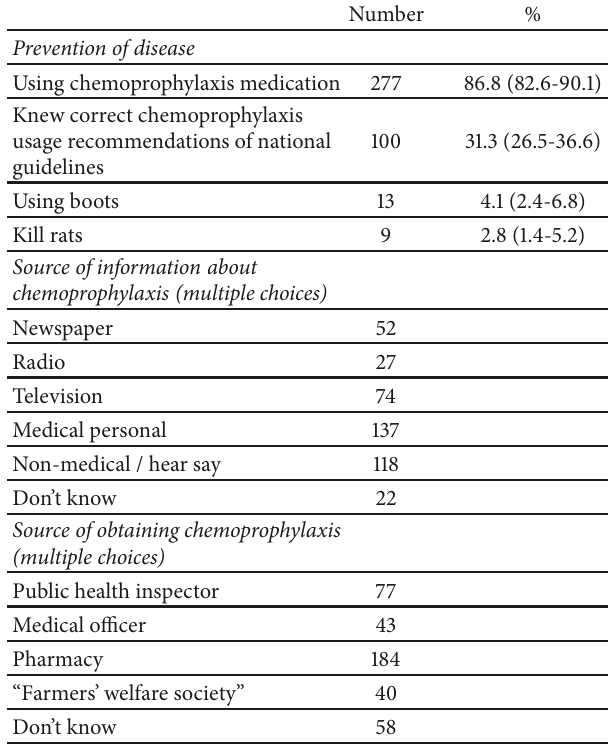
Table 4: Knowledge and awareness of farmers on modes of prevention of the disease, practice of using chemoprophylaxis with doxycycline.